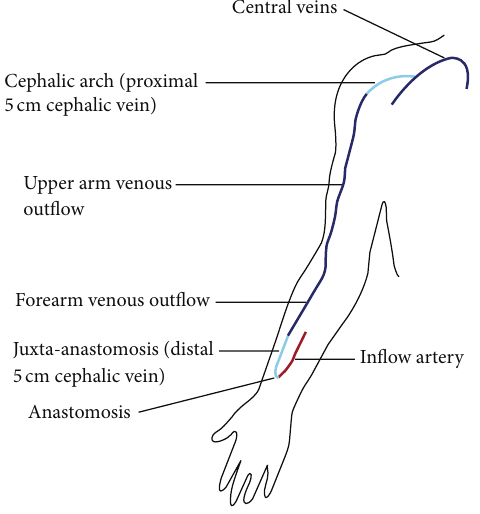
Figure 1: Locations of stent